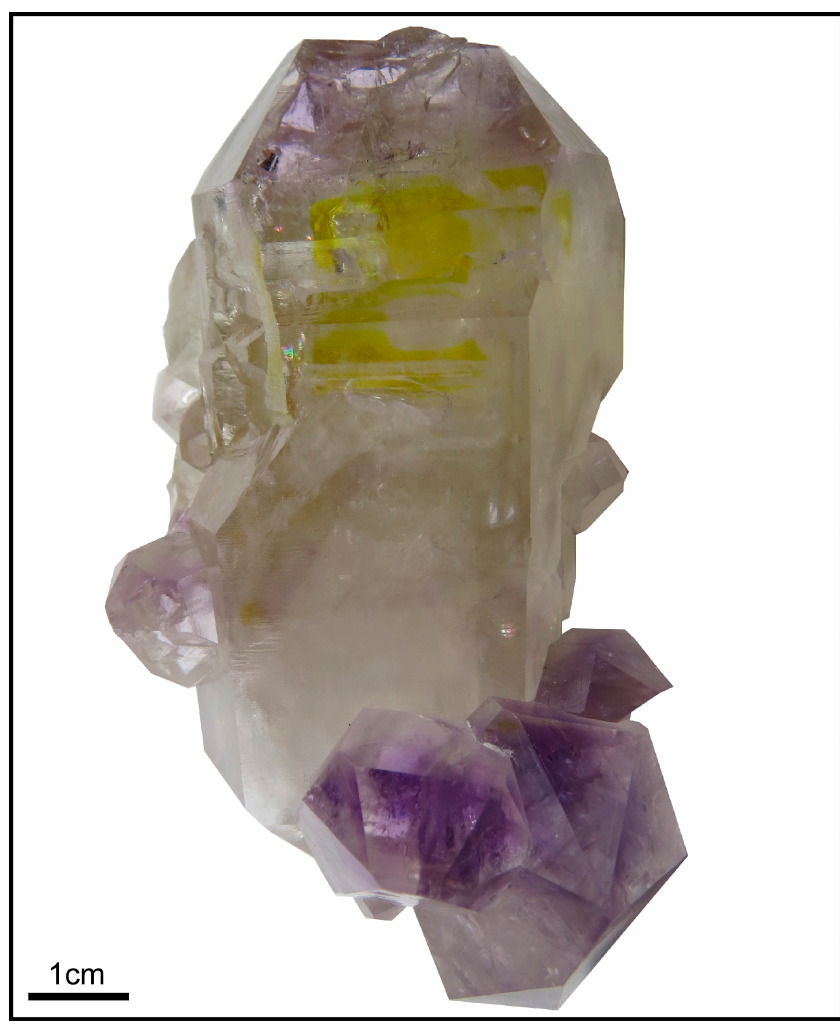
Figure 2. Photographs of a quartz-amethyst crystals with centimetric scale amber coloured oil inclusions (Type 3). The amber coloured phase in the inclusion is the liquid oil and it surrounds the colourless liquid phase.